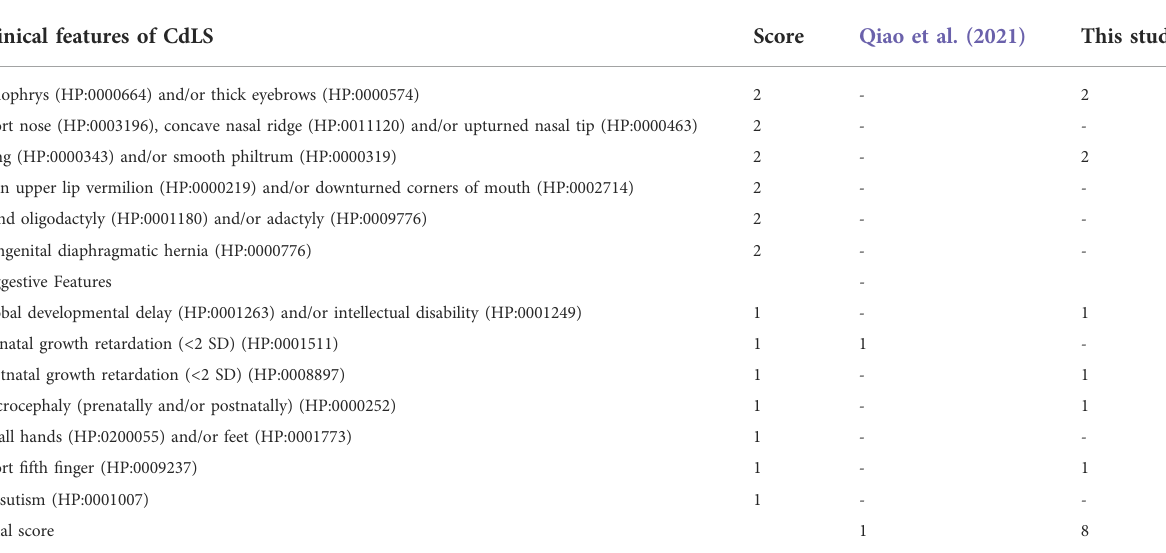
TABLE 1 Diagnostic algorithm as suggested by the Consensus Statement. Clinical features of CdLS Score Qiao et al.